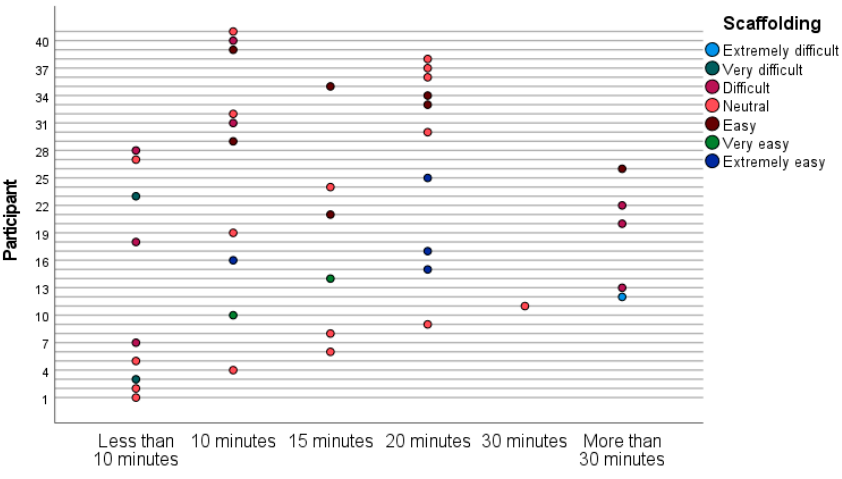
Figure 3. Perceived difficulty of the VRER layers correlated with the time required to complete the experience.